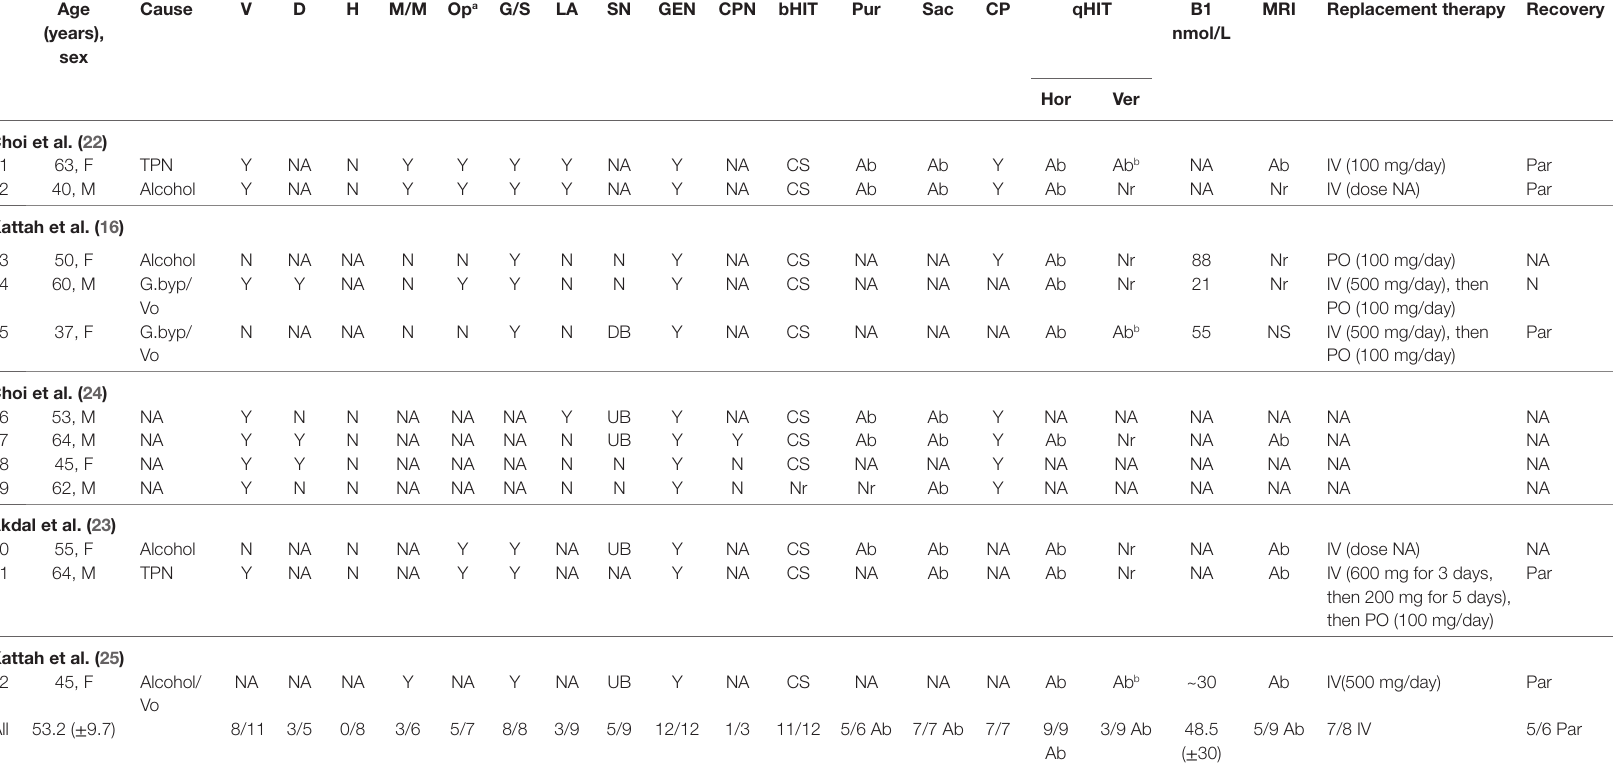
TaBle 3 | Clinical and neuro-otologic findings in selected cases with Wernicke’s encephalopathy reporting vestibular function (data from literature